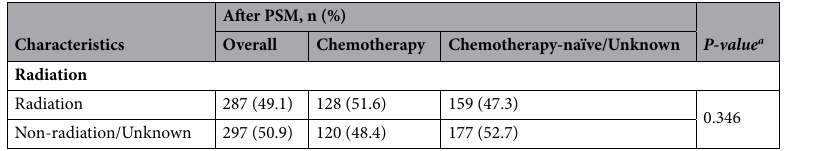
Table 1. Characteristics of female patients diagnosed with primary MpBC in SEER database. a P -value from Pearson’s chi-square test of independence. Abbreviations: DSW, divorced/separated/widowed; ER, estrogen receptor; HER2, human epidermal growth receptor 2; HR, hormone receptor; MpBC, Metaplastic breast